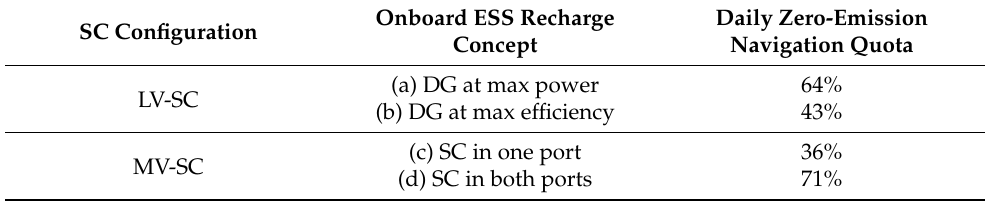
Table 10. Results in terms of zero emission navigation capabilities for the considered